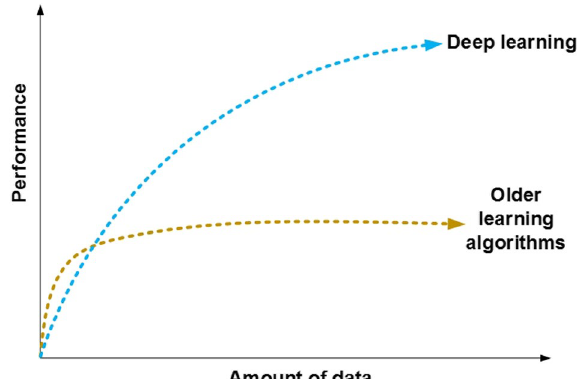
Fig. 5 The importance of large training data for DL models